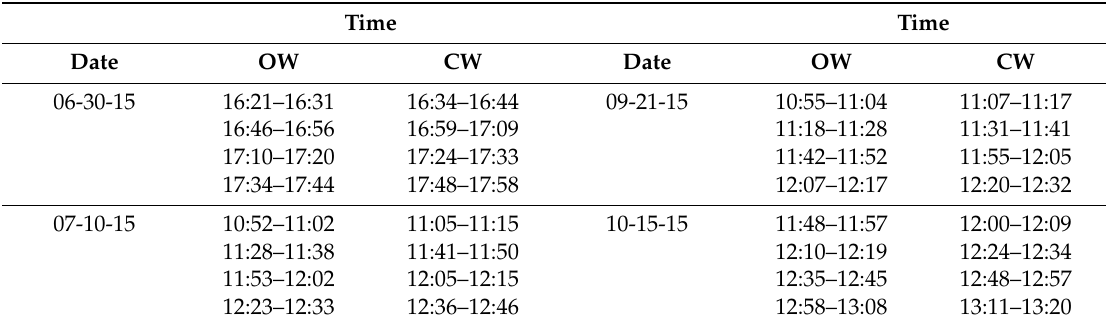
Table 2. Dates and time frames of the test rides through the residential area in